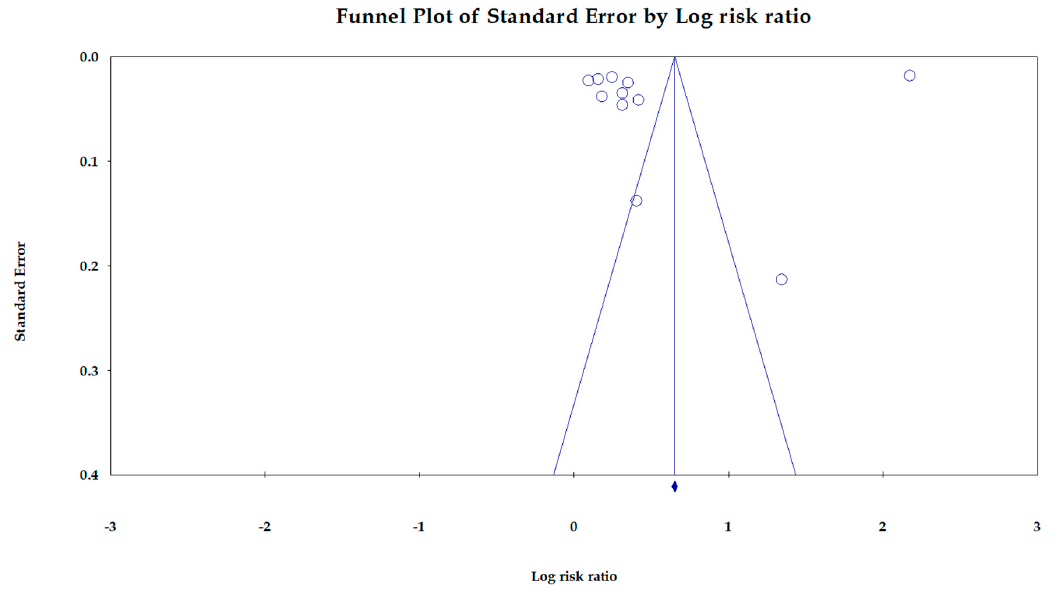
Figure 3. Funnel plot for the association between PPI use and the risk of CKD.